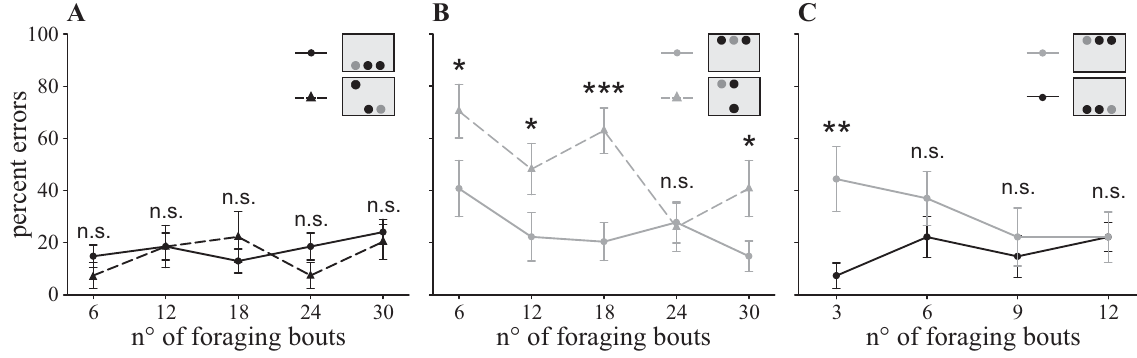
Figure 3. Search accuracy of honeybees depending on treatments. Error percentage at 5 cm distance to the search screen is shown for all three treatment groups. Treatments differed in the positioning of the rewarding target and distractors which were associated with a punishment (insets: grey circle = target, black circle = distractor). In the ‘dorsal group’ (straight grey line, grey circle) the target was always presented in the top row, in the ‘ventral group’ (straight black line, black circle) it was always located in the bottom row, and in the ‘mixed group’ the position of the target alternated randomly between both rows (top row: dashed grey line, grey triangle; bottom row: dashed black line, black triangle). A , B . Comparison between the one row condition and the two row condition separated in foraging bouts where the target appears in the bottom row ( A ) and bouts with the target in the top row ( B ). C . Comparison of the first 12 foraging bouts of the ‘dorsal group’ and the ‘ventral group’. Statistics: general linear model with binomial distribution: n.s. P>0.10, * P<0.05, ** P<0.01, *** P<0.001; data points: mean ± s.e.m., N=9 individuals per